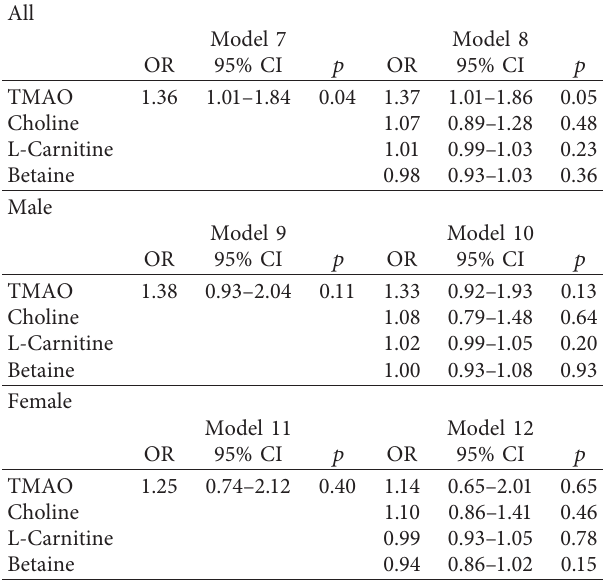
Table 3: Association of TMAO, choline, L-carnitine, and betaine levels with severe artery stenosis in all, male, and female